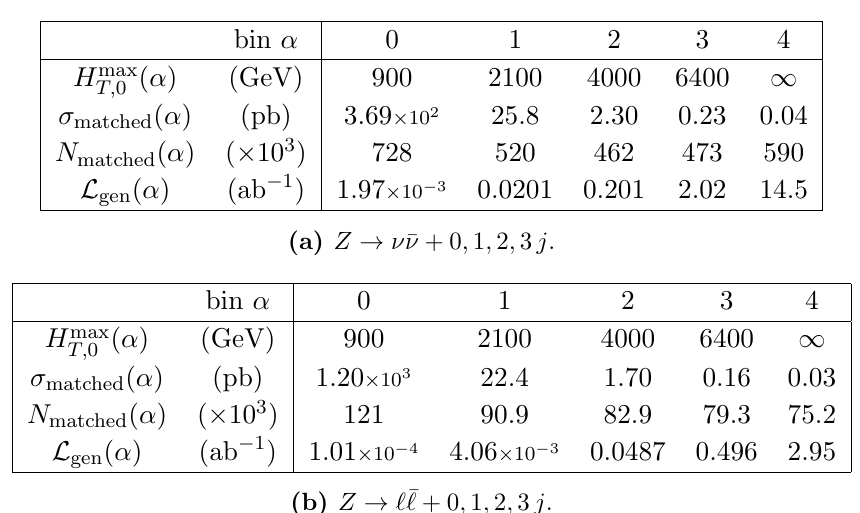
Table 9. Sample points for signal events. We generate 50000 events for each sample point.